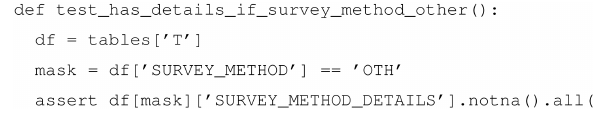
Figure 6. Sample Python code testing whether SURVEY_METHOD_DETAILS is provided whenever SURVEY_METHOD is “OTH”